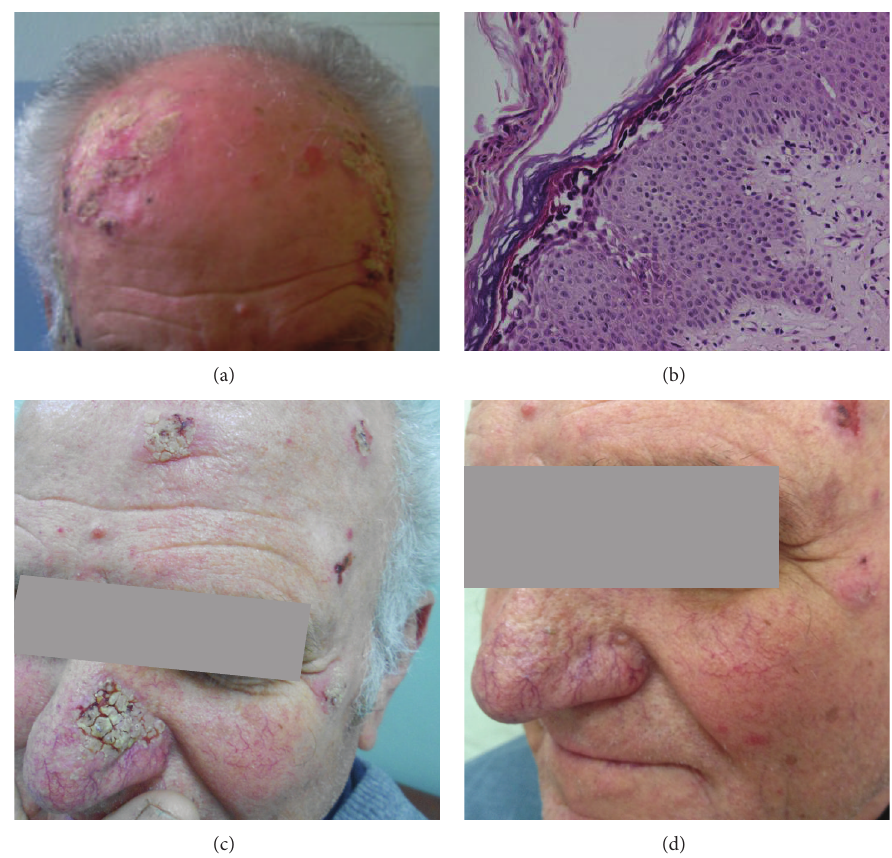
Figure 1: (a) Markedly hyperkeratotic scaling and erosions on scalp. (b) Subcorneal vesicle with a small number of dyskeratotic granular cells (H&E × 40). (c) Erosions and hyperkeratotic, cobblestone-like crusting on the nose of the same patient. (d) Clearance of lesions six months after the end of the pimecrolimus